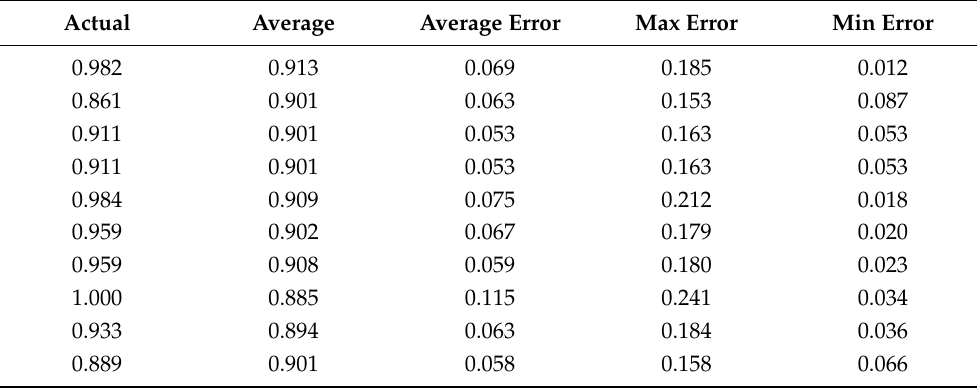
Table A18. Set 1, trials 11–20 data (actual PR